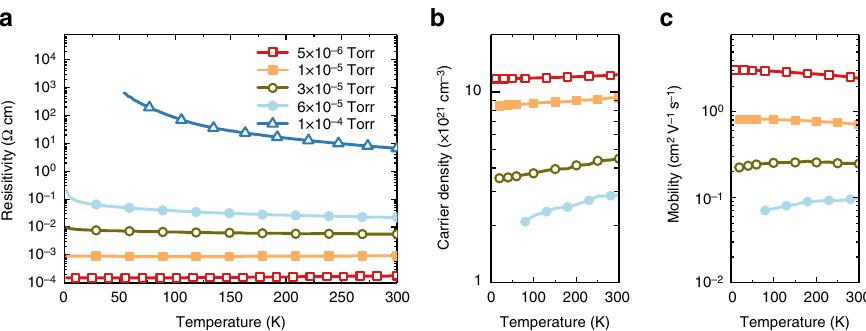
Figure 1 | Electronic transport properties of SrNbO 3 þ d films. Temperature-dependent transport properties of the films prepared at various oxygen pressures: ( a ) resistivity, ( b ) mobile electron density obtained from Hall measurement and ( c ) electron mobility of